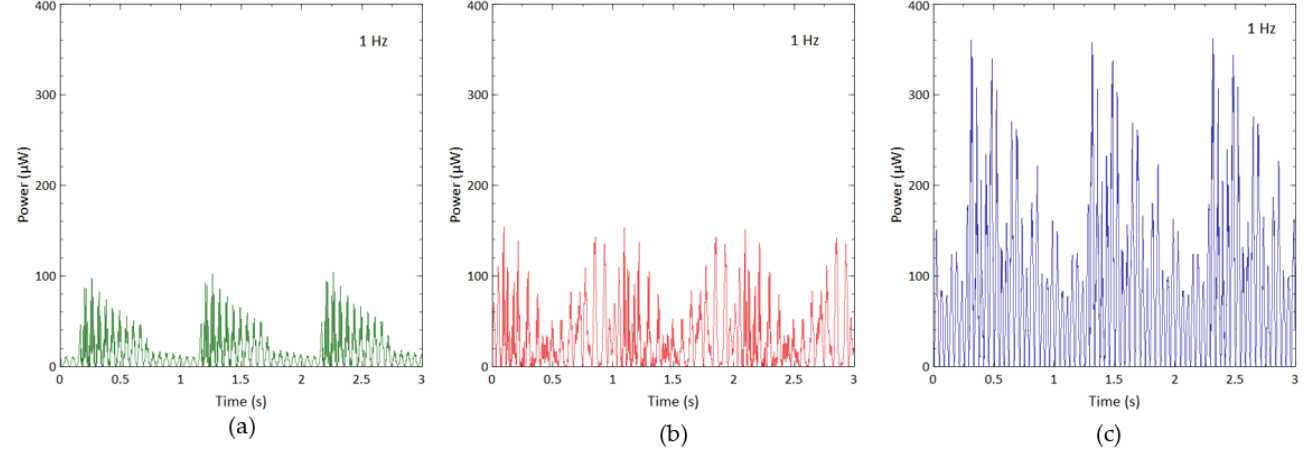
Figure 9. Output power of ( a ) CBH, ( b ) VBH, and ( c ) BBBH when excited under 1 Hz and 1 g acceleration.